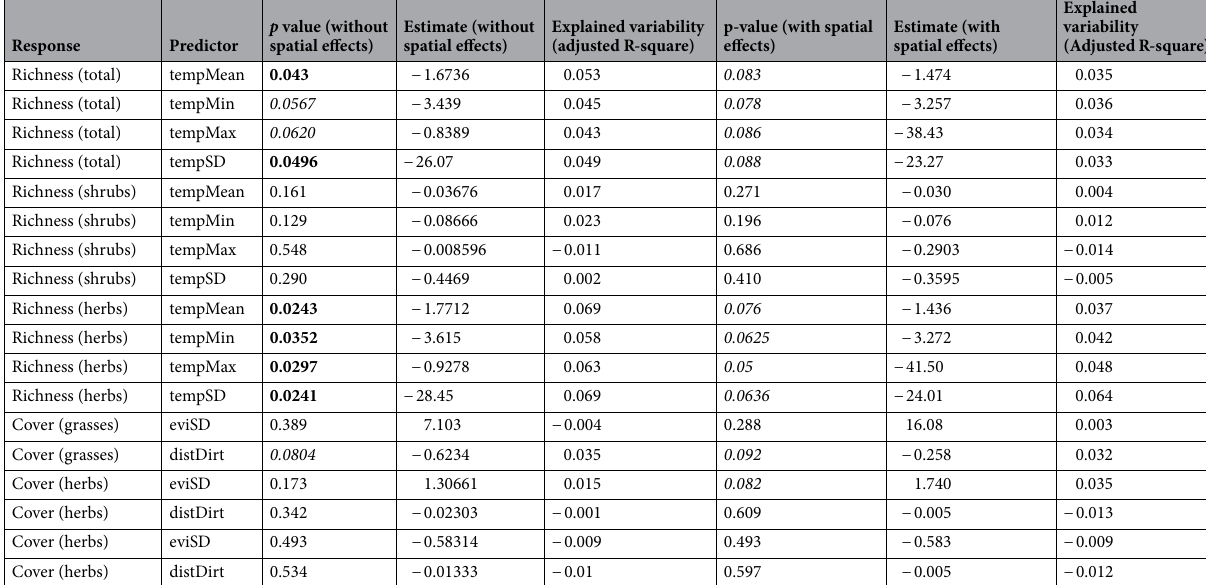
Table 4. The results of univariate regression models testing the relationships between the large-scale predictors, identified as significant by the ordination models (Table 3), and measures of plant species richness and cover in plots in the Kruger National Park. For each response variable, values from models not considering spatial effects as well as those with significant principal coordinates (PCO1, PCO2, PCO3) included to account for spatial effects are presented. Significant effects are displayed in bold, marginally significant in italics. See Supplementary Table 1 for description of predictor